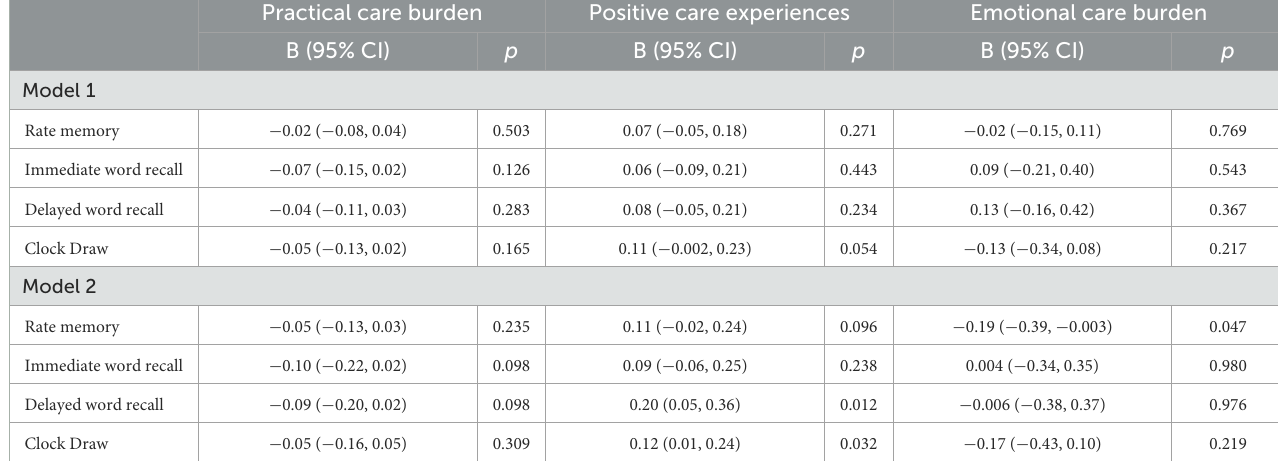
TABLE 4 Associaiton between caregiver experience and care recipient cognitive test performance among care recipients living with dementia.